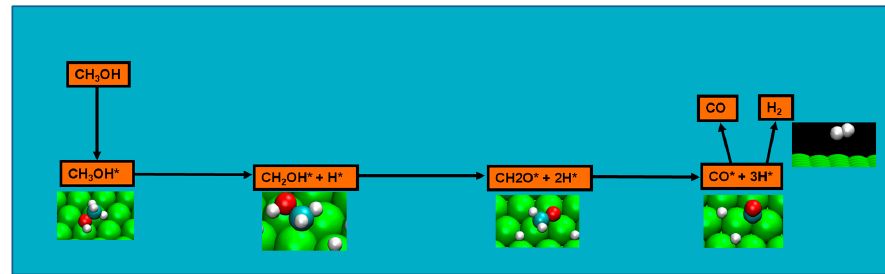
Figure 3. Representation of the methanol decomposition via hybrid route (I). Red color stands for oxygen, blue for carbon, white for hydrogen and green for ruthenium.